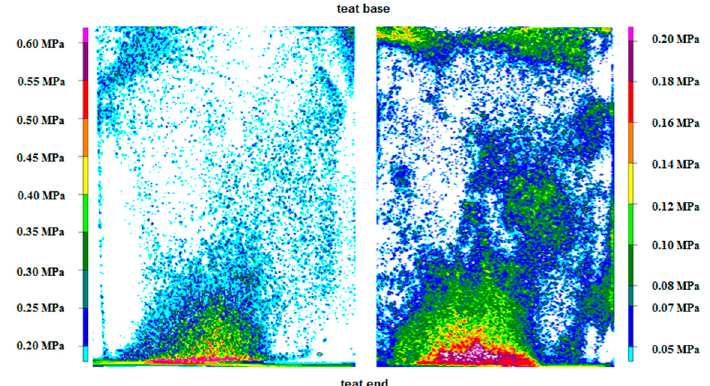
Figure 4. Pressure levels and pressure distribution on a silicone teat caused by the collapsing liner measured with Film 1 ( left ) and Film 2 ( right ).